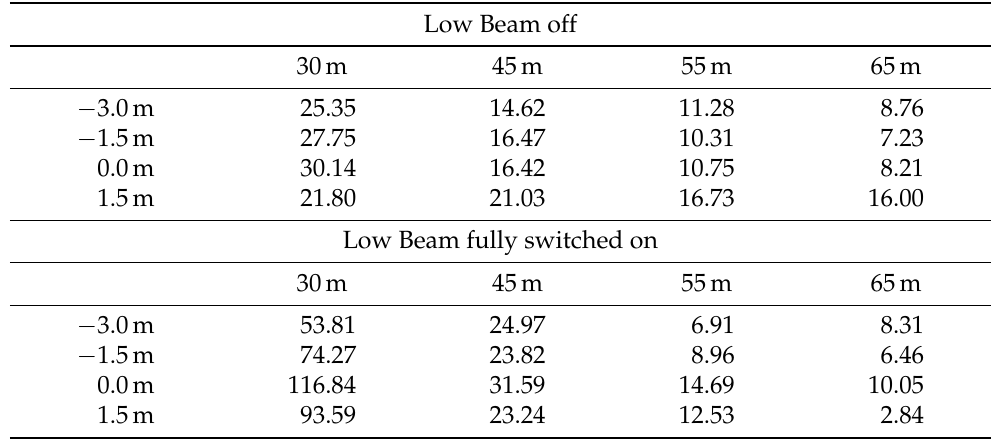
Table 4. Calculated Visibility Levels for test road 2, vehicle position